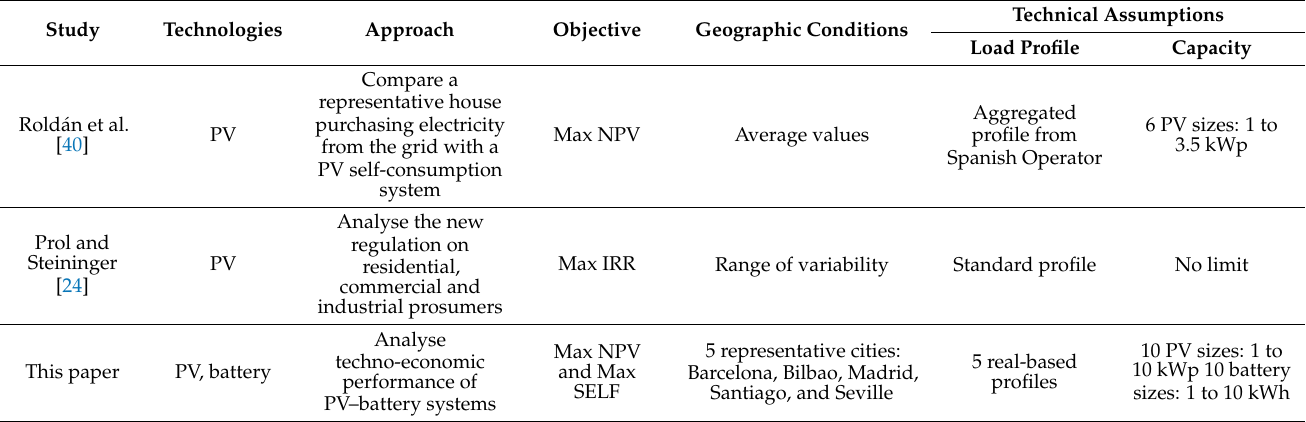
Table 1. Grid-connected photovoltaic (PV) economic studies under current self-consumption Spanish regulation. NPV: net present value; IRR: internal rate of return; SELF: